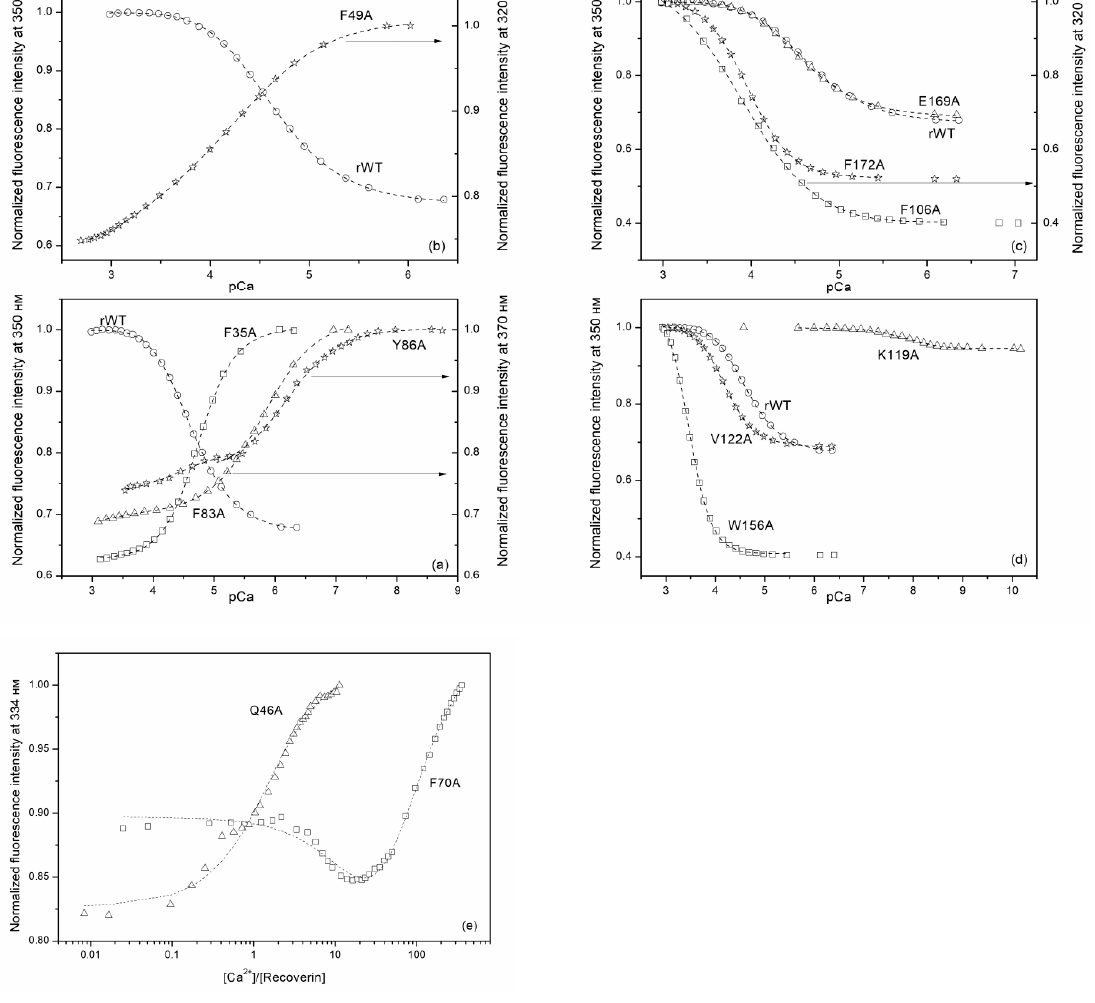
Figure6. SpectrofluorometricCa 2 + -titrationofrWThumanrecoverinanditsclustermutants(( a )—‘black’ cluster of the N-domain, ( b )—‘gray’ cluster of the N-domain, ( c )—‘black’ cluster of the C-domain, ( d )—‘gray’ cluster of the C-domain (the calcium bu ff er method), ( e )—‘gray’ cluster of the N-domain (proteintitrationbyCa 2 + ))at20 ◦ CwiththeuseofCa 2 + -bu ff ers. 50mM2-[N-morpholino]ethanesulfonic acid (MES)-KOH, pH 6.3 or 4-(2-hydroxyethyl)-1-piperazineethanesulfonic acid (HEPES)-KOH pH 7.5, or 3-(N-morpholino)propanesulfonic acid (MOPS)-KOH pH 6.7–7.2, or 20 mM Tricine-KOH pH 7.4–8.2, 50 mM KCl, 1–2 mM diethylenetriaminepentaacetic acid (DTPA)-KOH (in case of protein titration by Ca 2 + was not used), 1 mM DTT. Protein concentration 0.9–3.1 µ M, Ca 2 + concentration 20 µ M–10 mM. Dotted lines are computed according to the sequential or cooperative (only for F172A and W156A mutants) binding schemes and fitted to the experimental